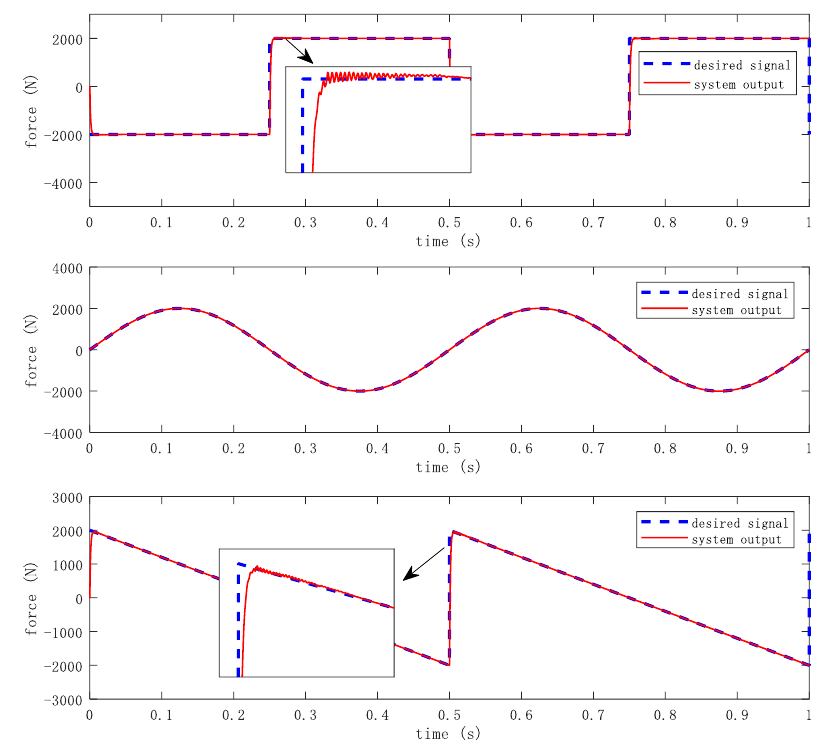
Figure 12. Control effect diagram without system interference.